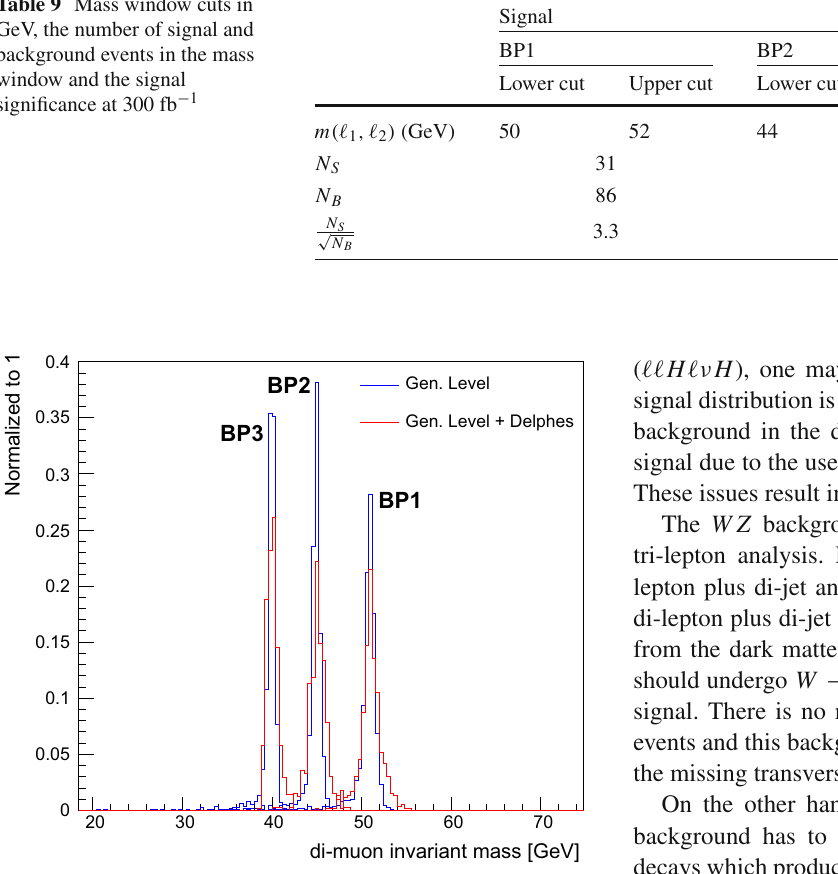
Fig. 11 The distribution of di-lepton pair invariant mass in signal ( (cid:2)(cid:2) jjH H ) with and without detector simulation (CMS) using Delphes